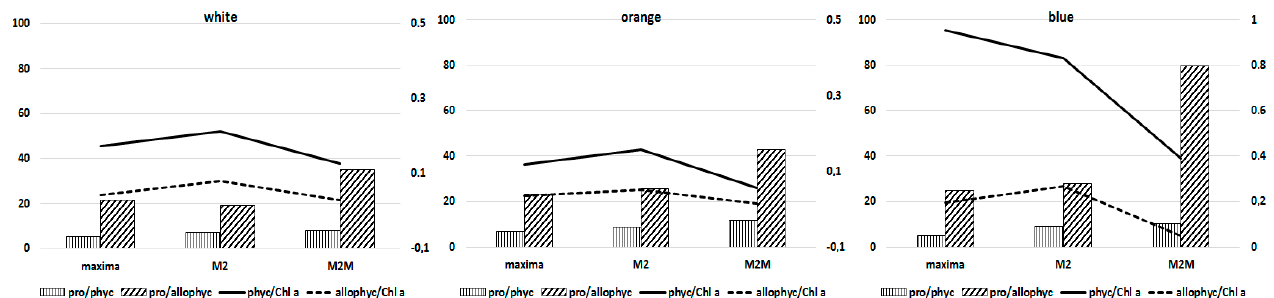
Figure 4. Biochemical composition of the three Arthrospira strains following exposure to white, orange and blue lights.